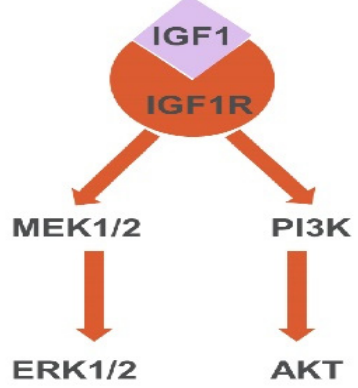
Figure 9. A schematic presentation summarizing the IGF1-IGF1R downstream pathways in PPCs. The activation of IGF1R by IGF1 can lead to the induction and further activation of Akt and ERK